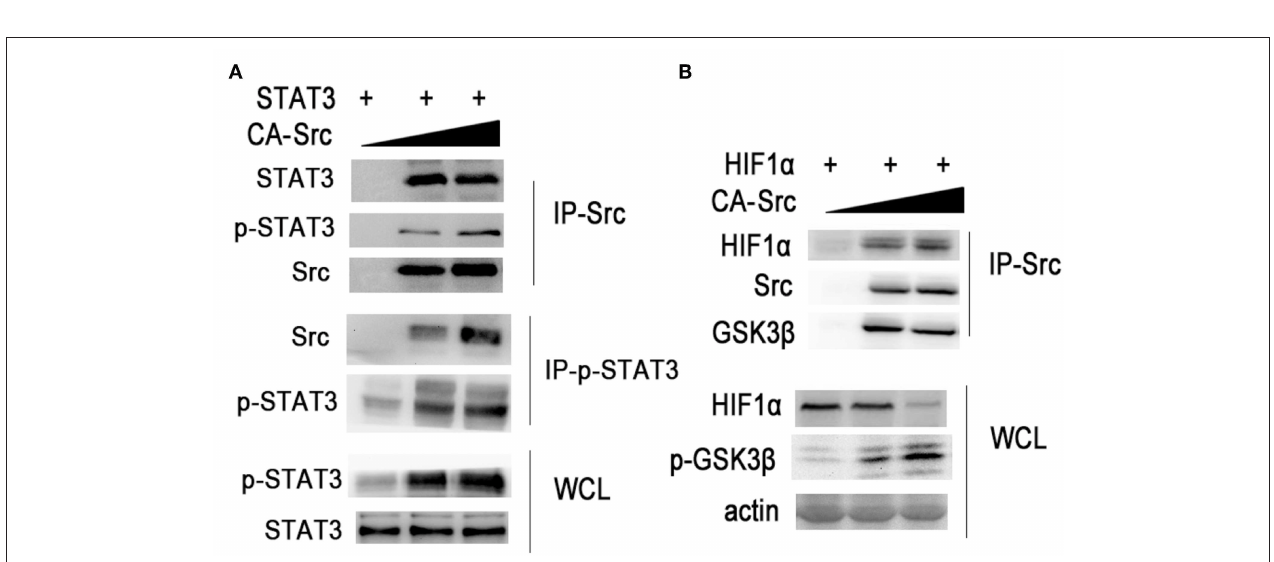
FIGURE 7 | Src regulates STAT3 and HIF1 α activation. (A,B) Immunoblotting of immunoprecipitated production or cell lysates from HEK293T cells overexpressing indicated plasmids with indicated antibodies. Data are representative of three independent experiments with similar results.